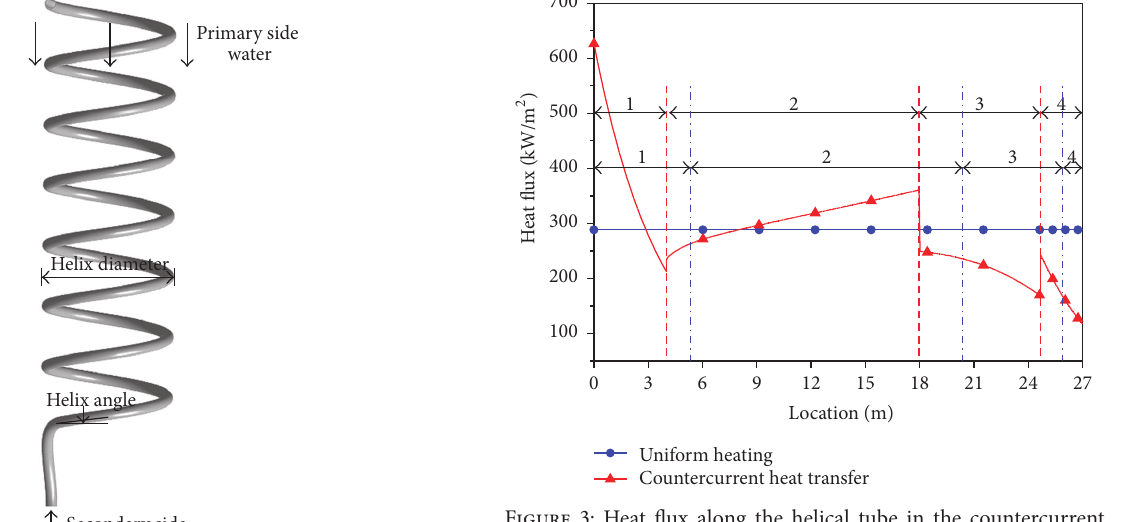
Figure 3: Heat flux along the helical tube in the countercurrent steam generator and uniform heating